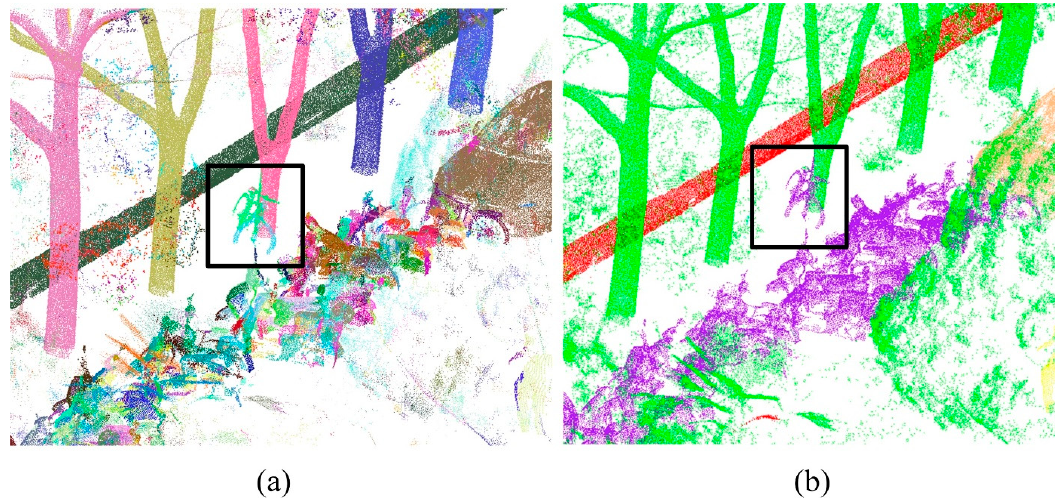
Figure 13. The results of the intersecting part processed by the proposed method. ( a ) Segmentation results by IN-Graph. ( b ) Classification results.